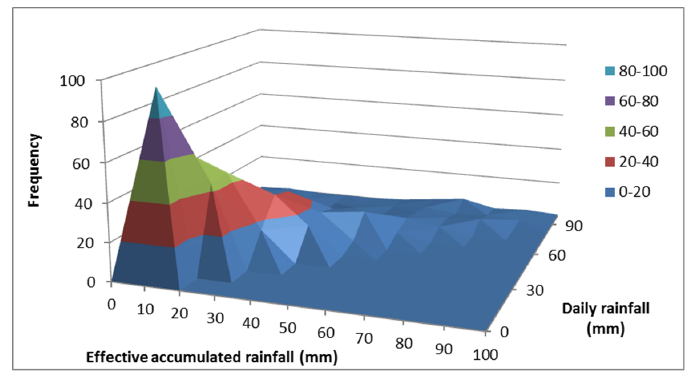
Figure 5. Frequency distribution of discrete rainfall groups at the Bihu rain gauge.